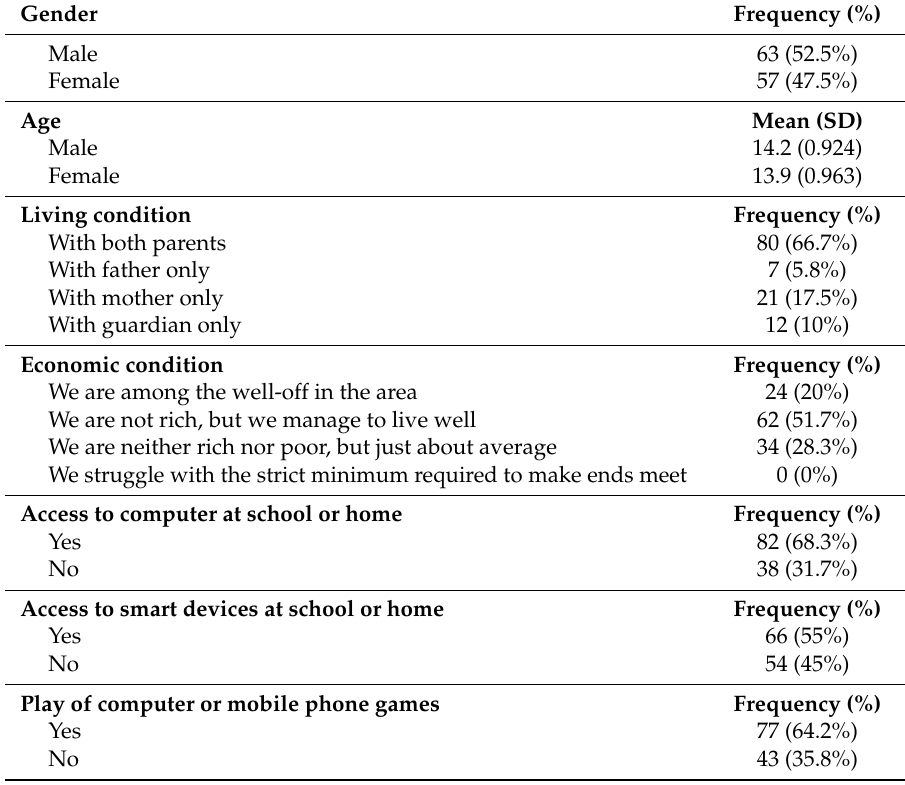
Table 2. Descriptive statistics of the students and SES and media usage characteristics ( N =